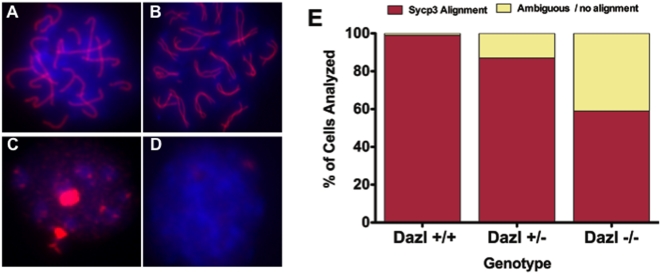

Dazl is required for Meiotic Progression, but Not for Entry into Meiosis.Results of analysis of 100 cells/genotype FACS isolated E17.5 Oct4ΔPE:GFP-positive cells, immunostained for SYCP3 (red) to indicate pachytene stage chromosomal alignment of Prophase I, and DAPI (blue) to label the nucleus. (A) Wildtype germ cell in pachytene. (B) Dazl−/− mutant germ cell in late zygotene/early pachytene. (C) Dazl−/− mutant germ cell displaying non-aligned SYCP3 staining. (D) Dazl−/− mutant germ cell displaying no SYCP3 staining. (E) Bar graph displaying percentage of cells per 100 cells/genotype showing appropriate SYCP3 alignment (A, B, red bars), and percentage of cells determined to be ambiguous or not showing SYPC3 alignment (yellow bars).